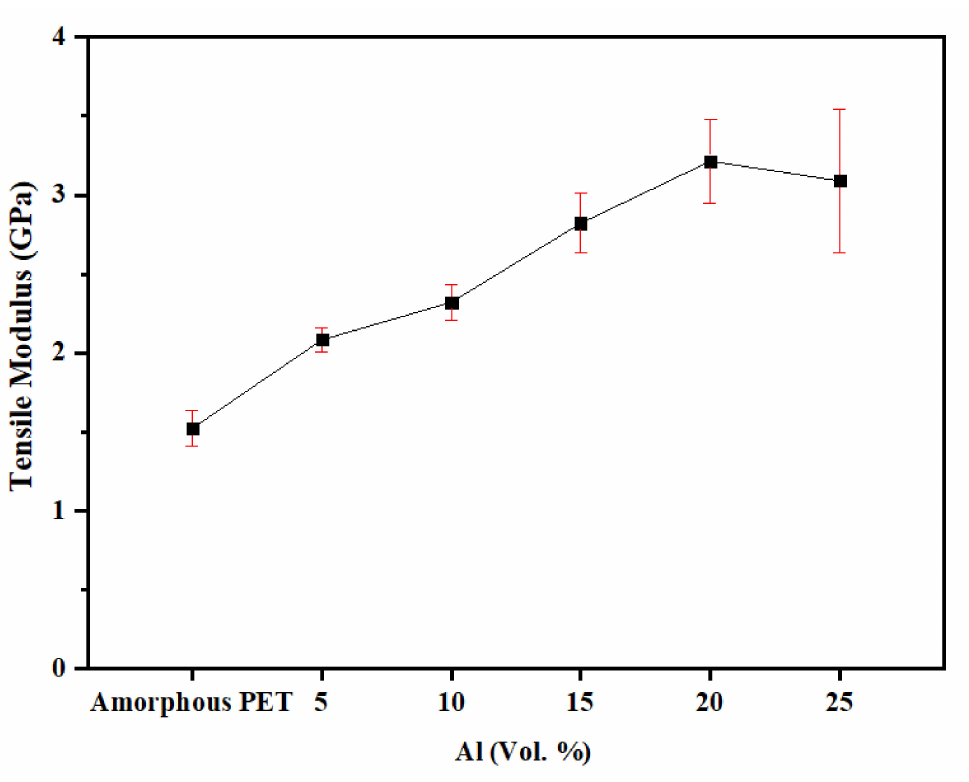
Figure 7. Tensile modulus of amorphous PET filled with Al nano platelets.